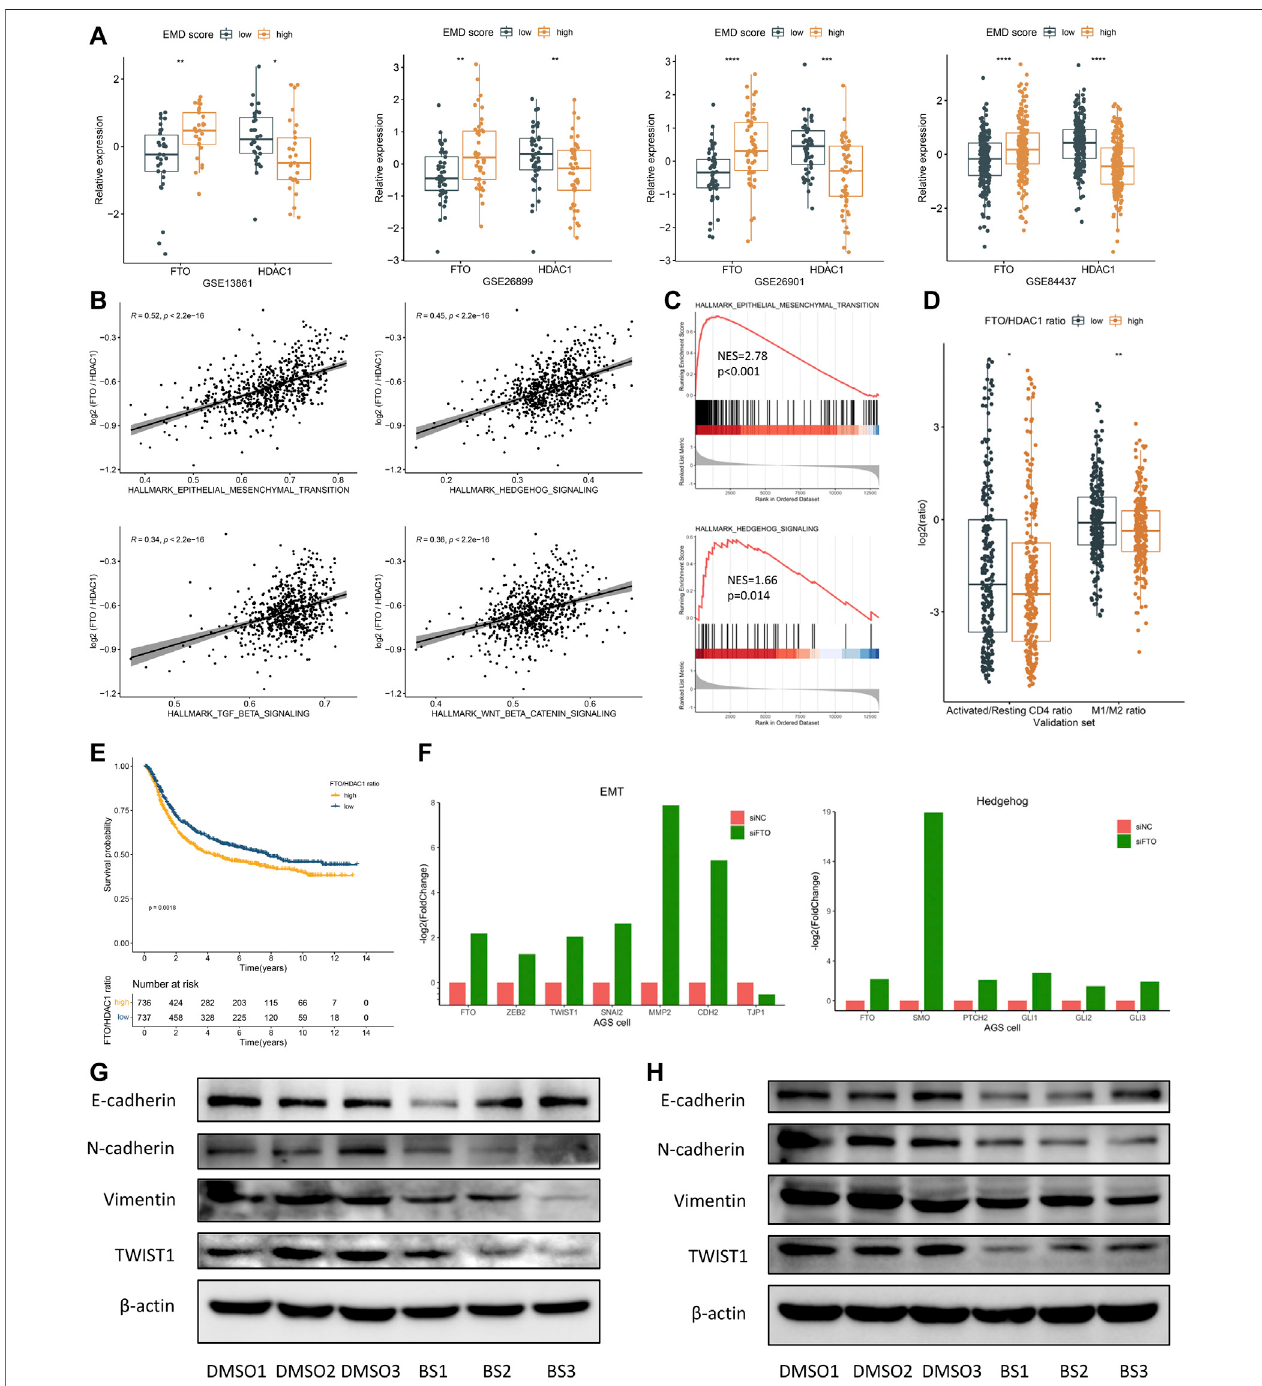
FIGURE 8 | FTO may serve as a potential target for patients with a high EMD score. (A) Correlations of the EMD score with FTO and HDAC1 in each cohort of the validation set. (B) Correlations of the FTO/HDAC1 ratio with multiple pathways in the validation set. (C) GSEA analysis con fi rmed the activation of EMT and Hedgehog pathwaysinpatientswithahighFTO/HDAC1ratio. (D) CorrelationsoftheFTO/HDAC1ratiowiththeactivated/resting CD4 + Tcellratioand M1/M2ratiointhevalidation set. Activated/resting CD4 + T cell ratio refers to the ratio of activated CD4 + T cells and resting CD4 + T cells. The M1/M2 ratio refers to the ratio of macrophage M1 and macrophage M2. (E) Kaplan – Meier curves showed the different overall survival between the high and low FTO/HDAC1 ratio group in the whole cohort of this study. Patients were separated into high and lowgroups according to the median EMD score ofthe whole cohort. (F) Barplots showed the fold change of EMT and Hedgehog markers under FTO depletion in the AGS cell line (GSE178697). (G) Western blot showed the suppression of the EMT pathway under FTO inhibition in the SNU719 cell line. (H) WesternblotshowedthesuppressionoftheEMTpathwayunderFTOinhibitionintheSGC7901cellline(* p < 0.05,** p < 0.01,*** p < 0.001,and**** p < 0.0001).